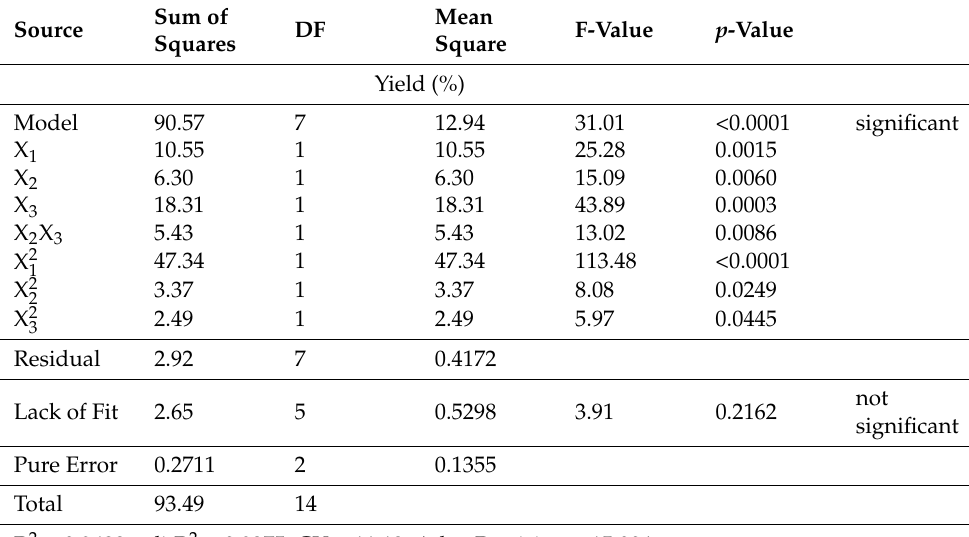
Table 3. ANOVA results for extraction efficiency and the total flavonoid